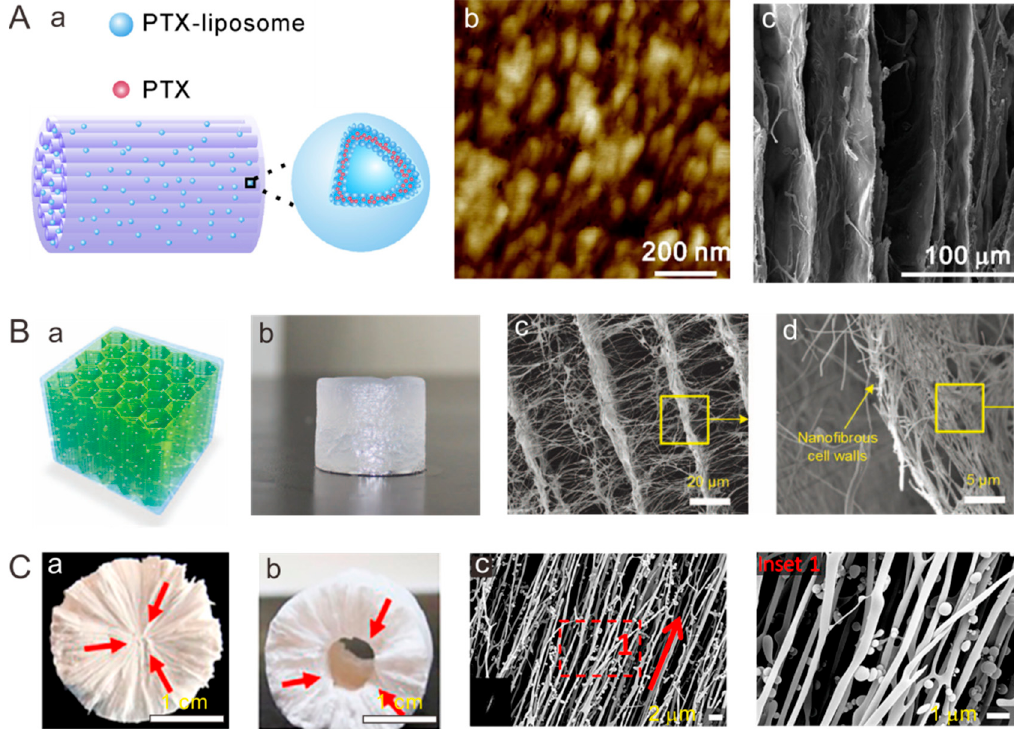
Figure 2. Representative aligned porous scaffolds produced by freeze drying. ( A ) Collagen scaffolds with arrayed microchannels loaded with drug-incorporated liposomes: ( a ) schematic of a drug-liposome loaded oriented collagen scaffold, ( b ) atomic force microscopy image of drug-liposomes, and ( c ) SEM image of an aligned collagen scaffold. Reprinted from Reference [27]. ( B ) 3D aligned cellular scaffold composed of electrospun nanofibers: ( a ) schematic of a nanofibrous scaffold, ( b ) a photograph of a hydrated nanofibrous scaffold, ( c ) SEM image of cellular architecture, and ( d ) SEM image of nanofibrous wall. Reprinted from Reference [29]. ( C ) 3D scaffolds with co-aligned nanofibers and macrochannels: ( a , b ) photographs of nanofibrous scaffolds in various geometries (a: cylinder, b: tube), and ( c ) SEM images of aligned silk fibroin nanofibrous scaffolds. Reprinted from Reference [30].